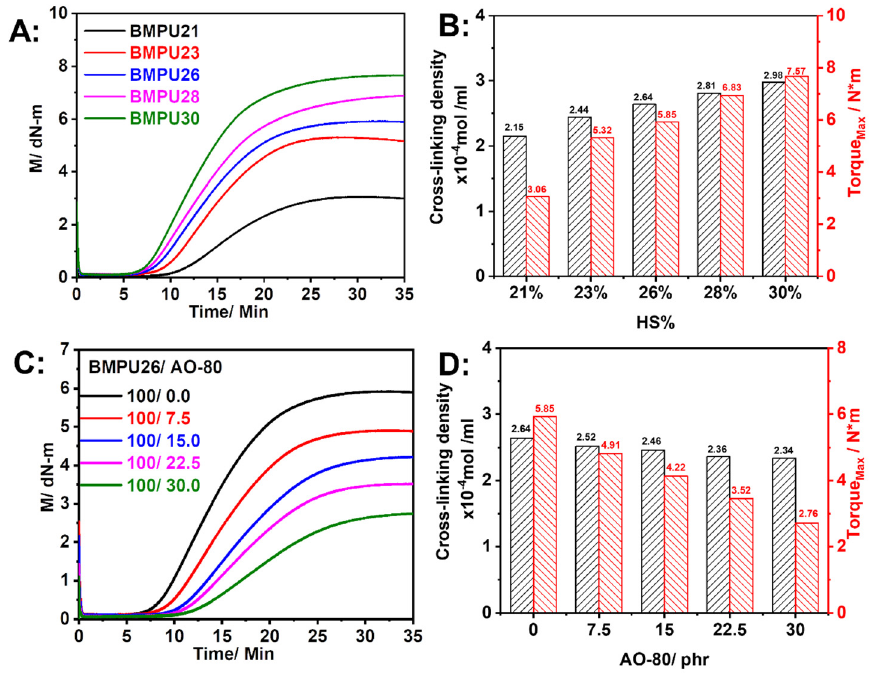
Figure 2. ( A ) Vulcanisation curves and ( B ) cross-linking density and torque Max of BMPUs. ( C ) Vulcanization curves, ( D ) cross-linking density, and torque Max of BMPU/AO-80 composites. The DSC curves of BMPU26 and BMPU26/AO-80(100/30) during curing at different